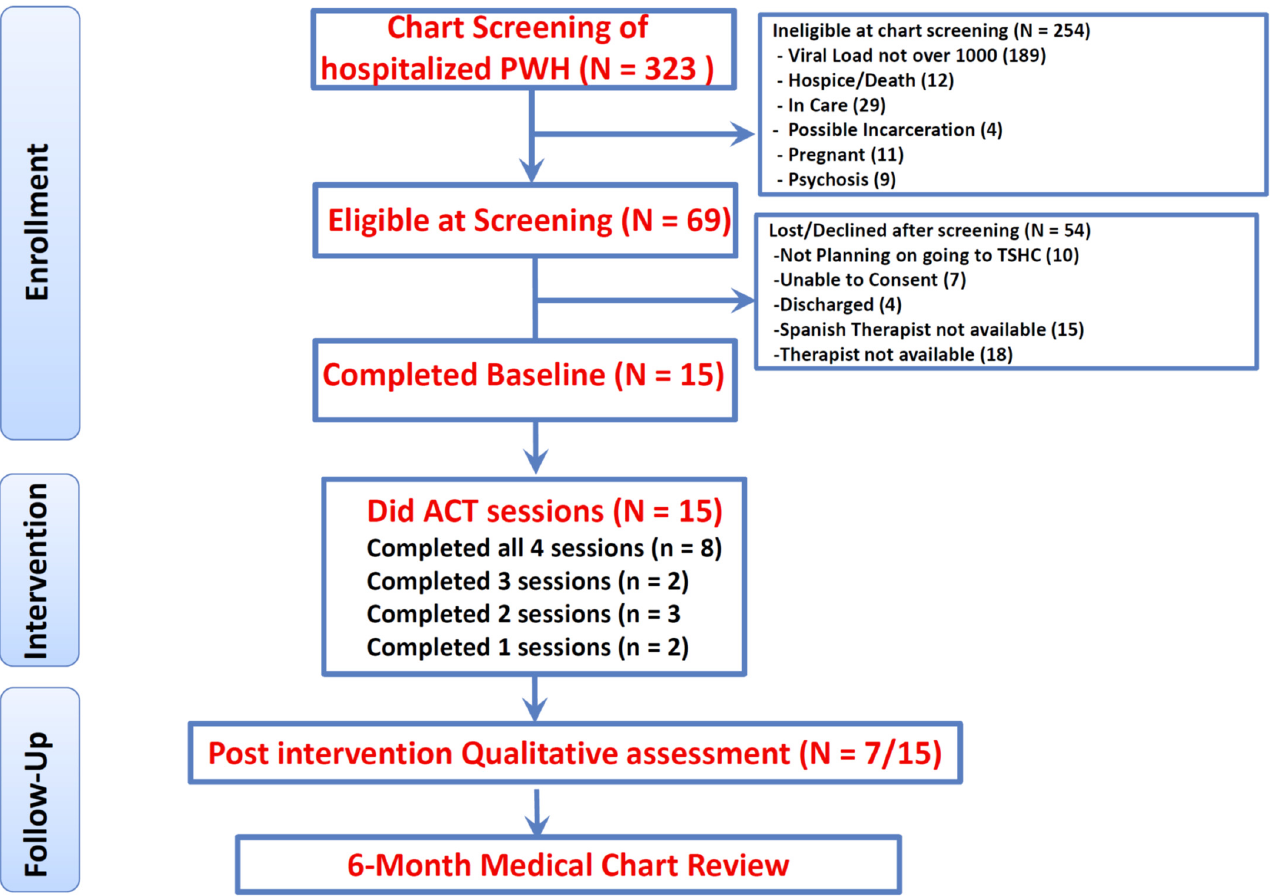
Figure 4. Consort diagram.